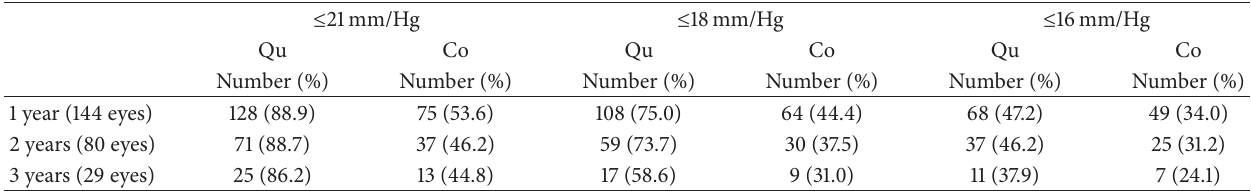
Table 2: Success rate.